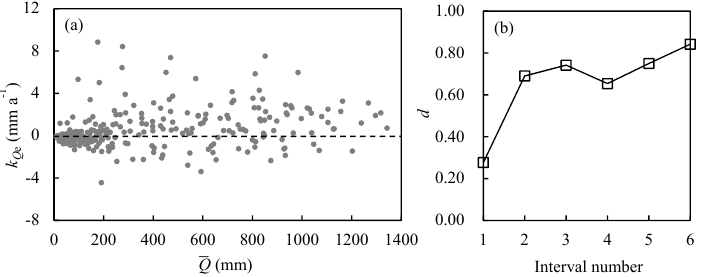
Figure 8. (a) Relationship between estimated runoff trends k Q and mean annual runoff Q for the study catchments during the period 1956– e 2000. (b) Values of d in each interval according to Q . Interval numbers 1 to 6 correspond to six intervals of 0–200, 200–400, 400–600, 600–800, 800–1000, and 1000–1400, respectively.